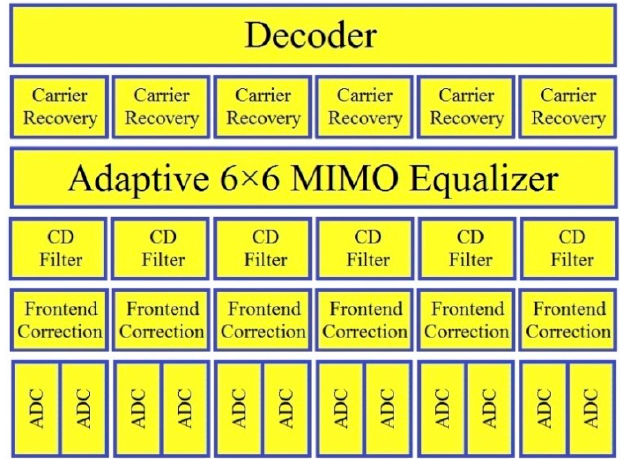
Figure 6. Typical DSP architecture for the MIMO equalization. ADC: analog-to-digital converter; CD: chromatic dispersion.